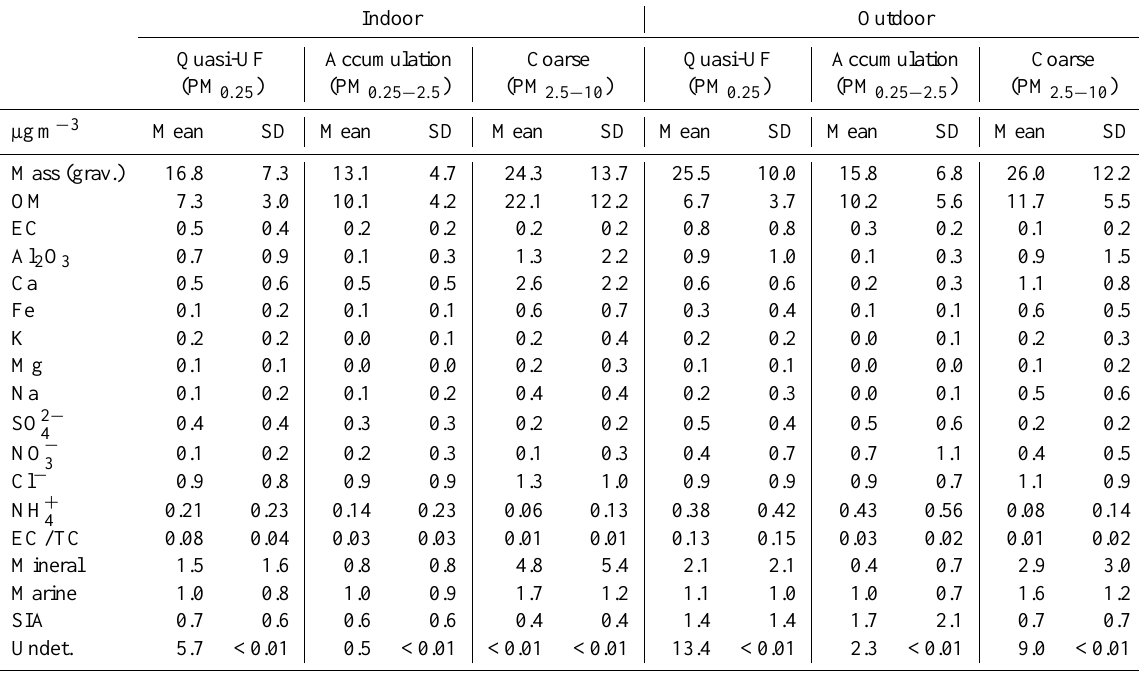
Table 1a. Mean concentration and standard deviation (SD) for major elements (in µgm − 3 ) in quasi-UF, accumulation and coarse mode particles in 39 schools in Barcelona. Mass (grav.): gravimetrically determined mass. Undet.: undetermined fraction. OM: organic mass. EC: elemental carbon. TC: total carbon. SIA: secondary inorganic